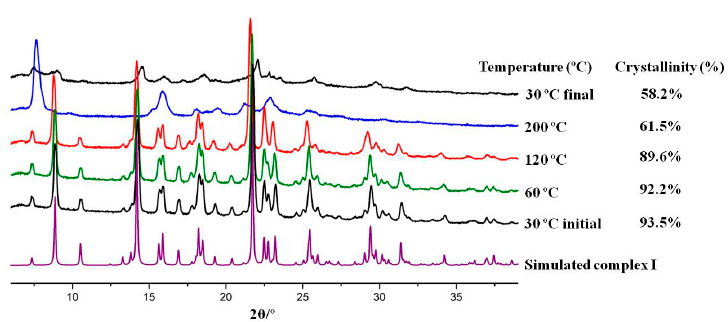
Figure 8. Variable temperature powder X-ray diffraction (VT-PXRD) of complex I recorded at five different temperatures and displaying different crystallinity patterns. The data obtained for complexes II and III is depicted in Figures S13–S14 in Supporting Information.